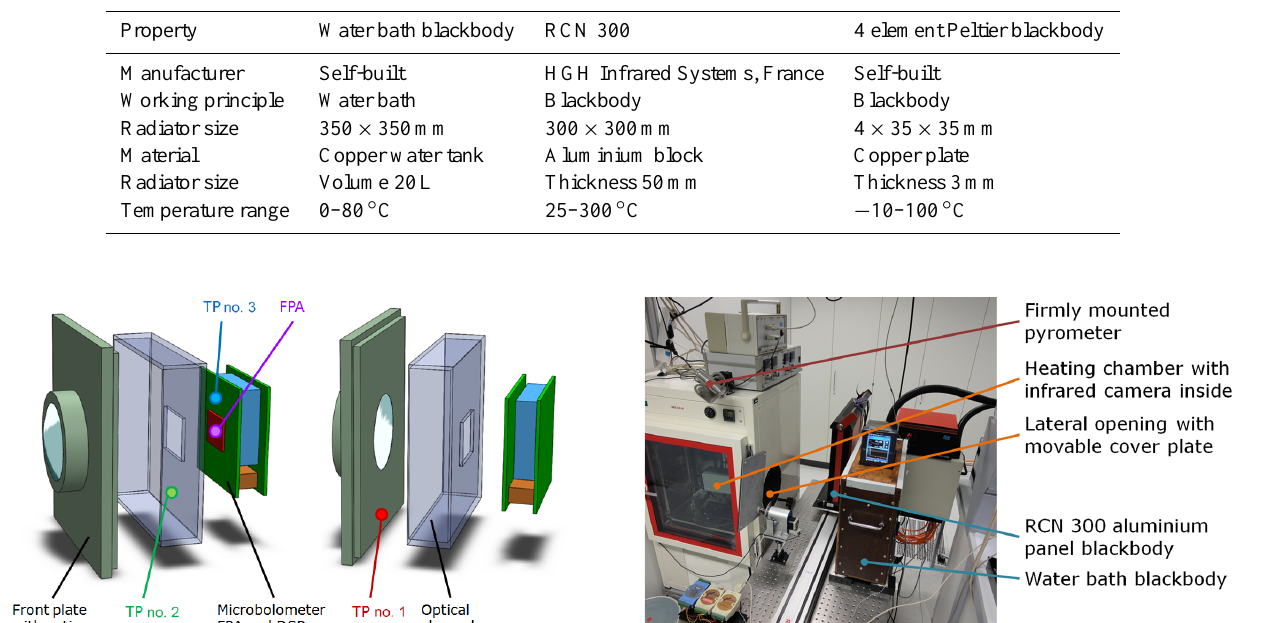
Table 2. Properties of the used blackbodies.